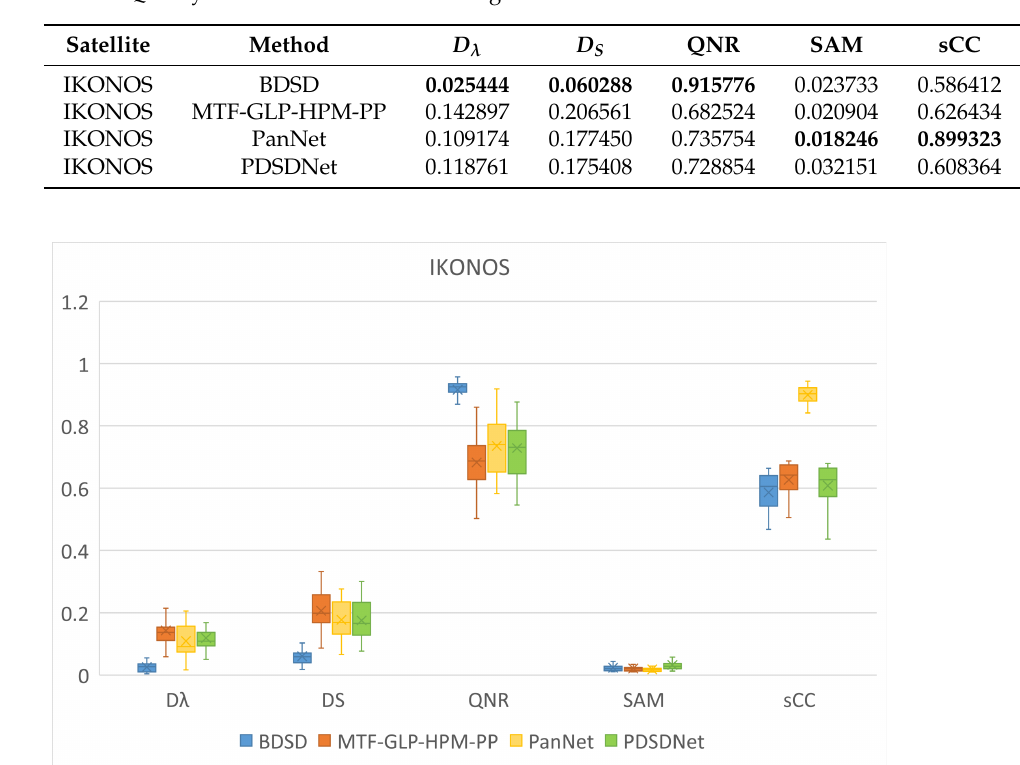
Table 4. Quality indexes of IKONOS test images.